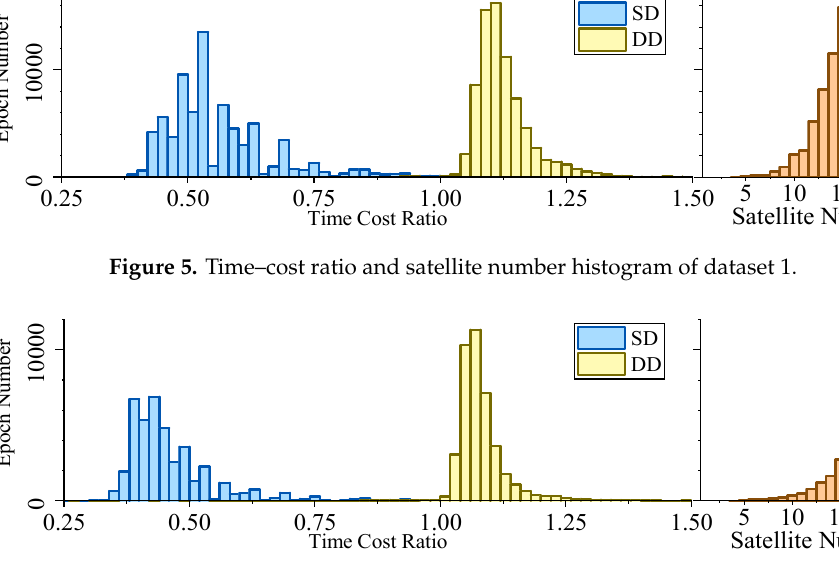
Figure 6. Time–cost ratio and satellite number histogram of dataset 2.